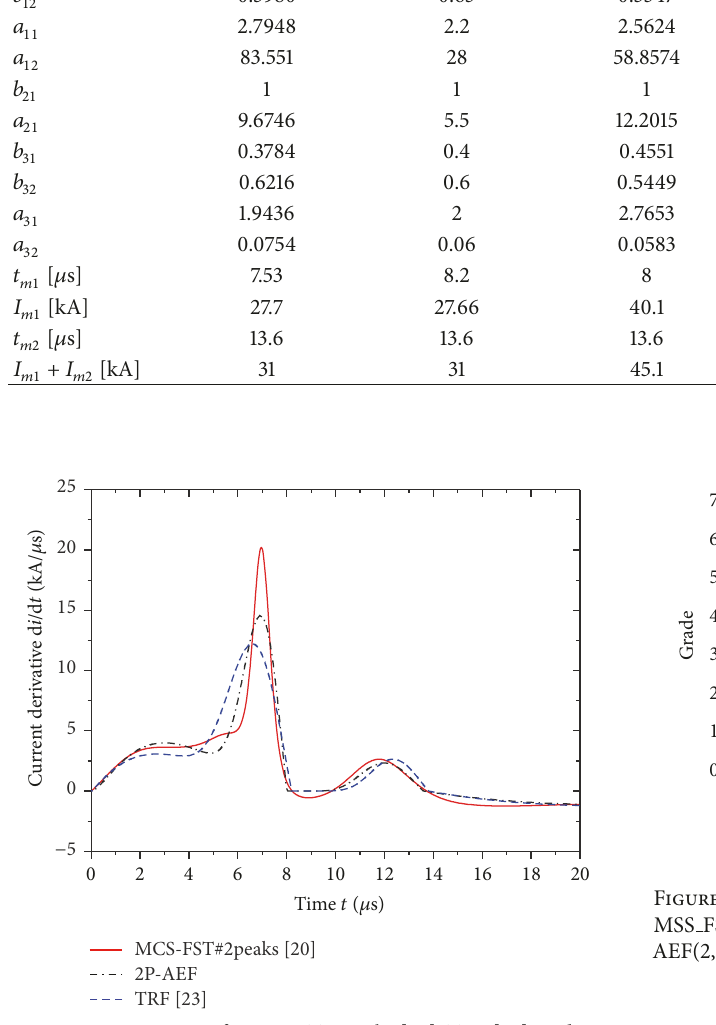
Figure 9: Derivatives of MCS FST#2peaks [20], TRF [23], and 2P- AEF(2,1,2).